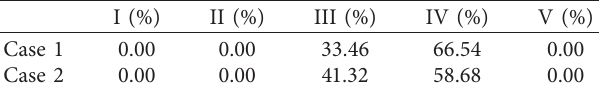
Table 6: Classification results of slope stability with the index